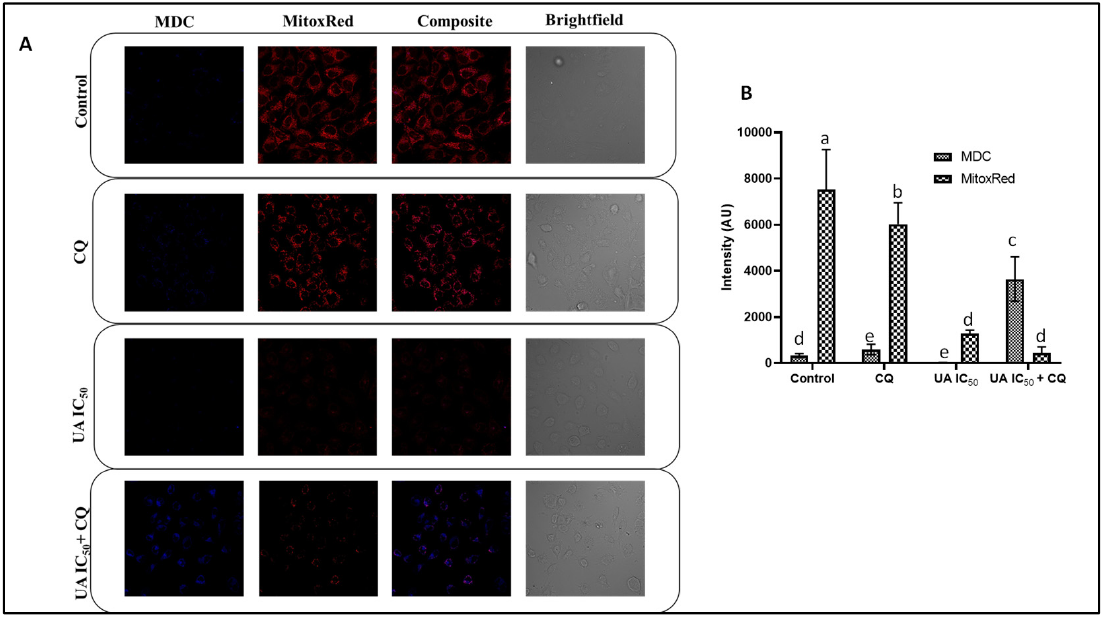
Figure 5. Confocal microscopy of UA-treated HeLa cells. ( A ) Evaluation of autophagy and MMP loss mediated by UA with or without CQ after 24 h of treatment. The cells were dual stained with MDC and MitoxRed and visualized via confocal microscopy. ( B ) Quantification of fluorescence intensities of stained HeLa cells using ImageJ software. Values are the means ± SD of three independent experiments. Means sharing different letters differ significantly from each other at p ≤ 0.05.